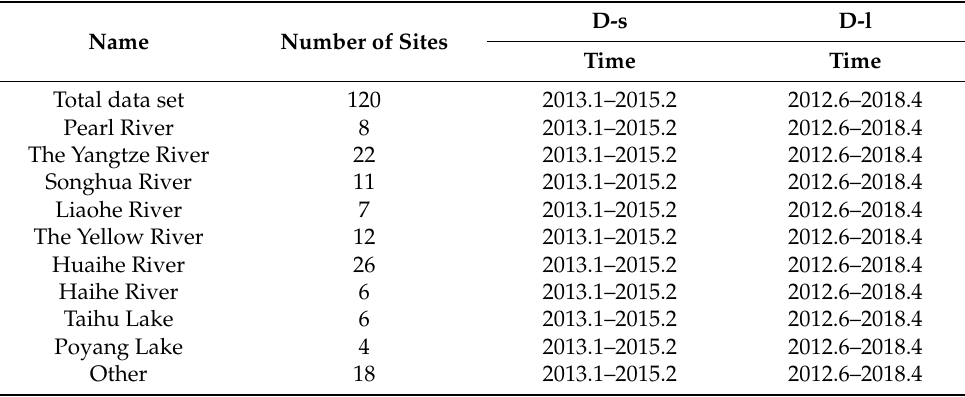
Table 2. Dataset